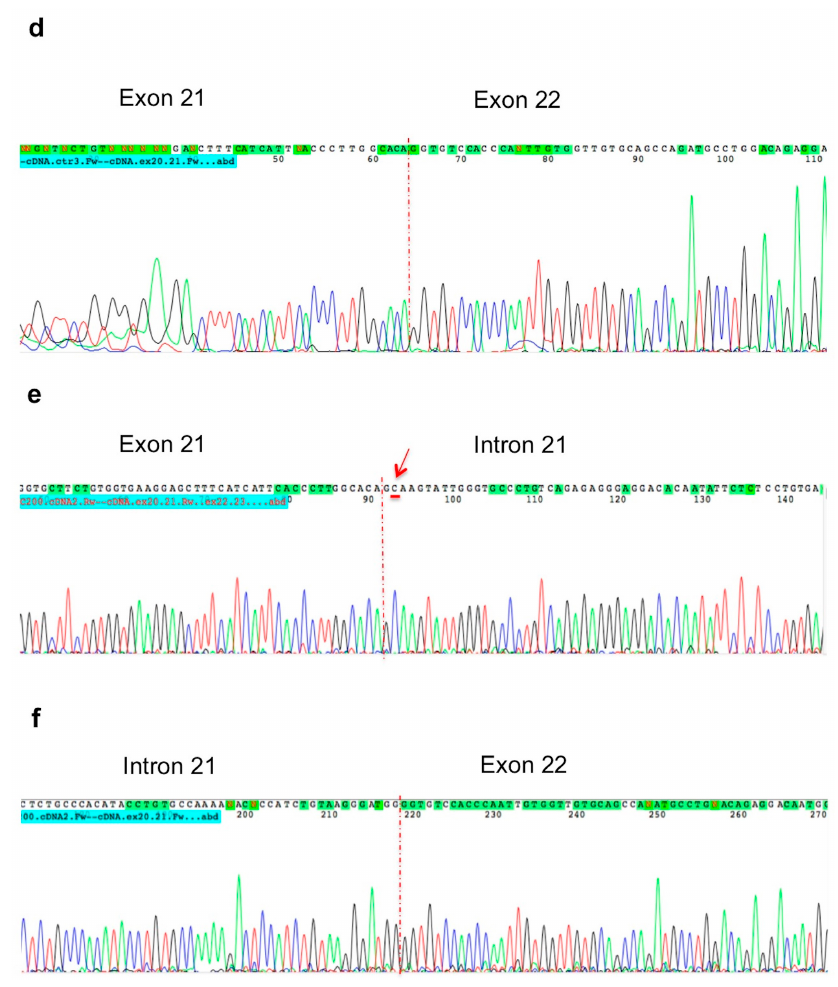
Figure 2. ( a ) DNA Chip 1K assay of the 825 bp amplification of the cDNAs of the patient and of the two women without BRCA1 and BRCA2 mutations (primers a and b, see Table 1). Lane 1 was loaded with the mutated cDNA that gave two amplification products: the 825 bp band represents the wt BRCA1 allele, while the intronic retention of mutated cDNA generated the other band, which was 156 bp longer than wt. Lanes 2 and 3 show the BRCA1 -amplified cDNA of the two control subjects (cDNA ctr1 and cDNA ctr2); ( b ) Peak view of the fluorescence results; ( c ) PCR amplifications to verify the splicing variant visualized on agarose gel at 1.2%. Lanes 1–5 show the results of the amplification on cDNA templates. Lane 1 shows the two bands derived from amplification of the mutated cDNA of the patient (825 and 981 bp); lanes 2 and 3 show the amplifications performed on the cDNA of the two women without BRCA1 and BRCA2 mutations; lane 4 was loaded with gDNA which shows that no products were generated consistent with the PCR reaction negative control (neg ctr) loaded in lane 5; lane L was loaded with 7 µL of size marker 1 kb; the red arrows show the wt and the mutated alleles, containing the intron retention; ( d ) Sanger sequencing of a healthy control cDNA showing exons 21 and 22 of the BRCA1 gene; ( e ) Sequence of the cDNA of the patient bearing the c.5406+2T>C splice variant (red arrow) showing the junctions between exon 21 and intron 21; and ( f ) between intron 21 and exon 22, hence the retention of 156 bp of intron 21.